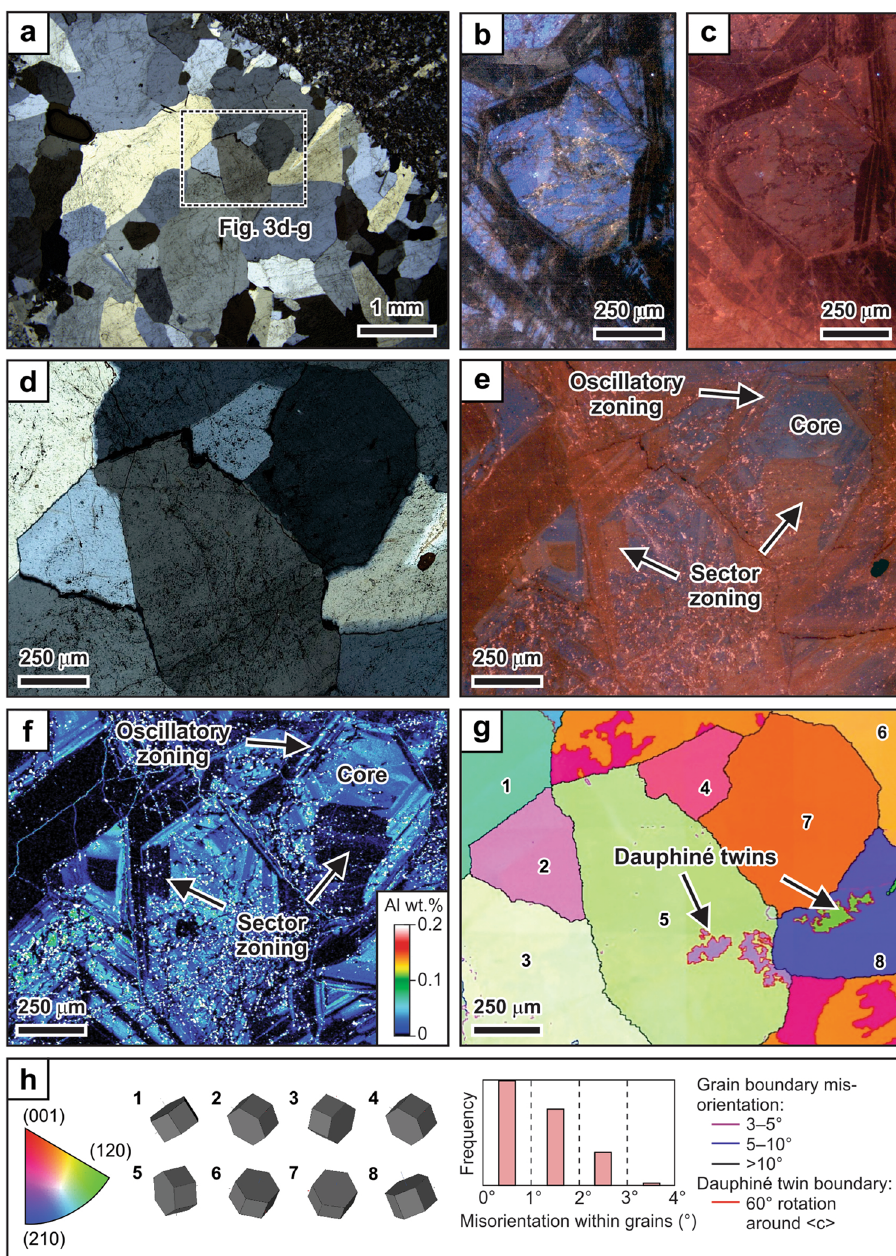
Figure 3. Petrographic characteristics of extensional vein quartz. ( a ) Vein consisting of elongate to blocky grains with planar or interlocking grain boundaries. ( b ) Cathodoluminescence image showing that the quartz grains have a short-lived (~ 15 s) blue emission. Quartz surrounding clusters of fluid inclusions affected by post-entrapment modification shows a yellow emission. ( c ) Long-lived (~ 100 s) red-brown to brown cathodoluminescence of quartz grains showing primary growth zoning. ( d ) Crossed-polarized light image of elongate and blocky quartz. ( e ) Corresponding long-lived (~ 300 s) cathodoluminescence image showing oscillatory and sector zoning of the grains. ( f ) Electron microprobe map of Al illustrating that the growth zones in the quartz grains observed by cathodoluminescence imaging are compositionally distinct. ( g ) Electron backscatter diffraction orientation map of elongate to blocky quartz grains. Grain orientations are represented by the different colors. Grain boundaries are color-coded depending on the grain boundary misorientation. Boundaries of Dauphiné twins are represented by the red lines. ( h ) Results of the electron backscatter diffraction analysis. The diagram on the left shows the color scheme used for the grain orientations relative to main crystal axis perpendicular to the map plane. The diagram in the middle shows a 3D representation of grain orientations of the numbered grains in ( g ). The histogram depicts the relative frequency of grains plotted as function of the changes in crystallographic orientation within individual grains. The internal misorientation does not exceed four degrees across individual